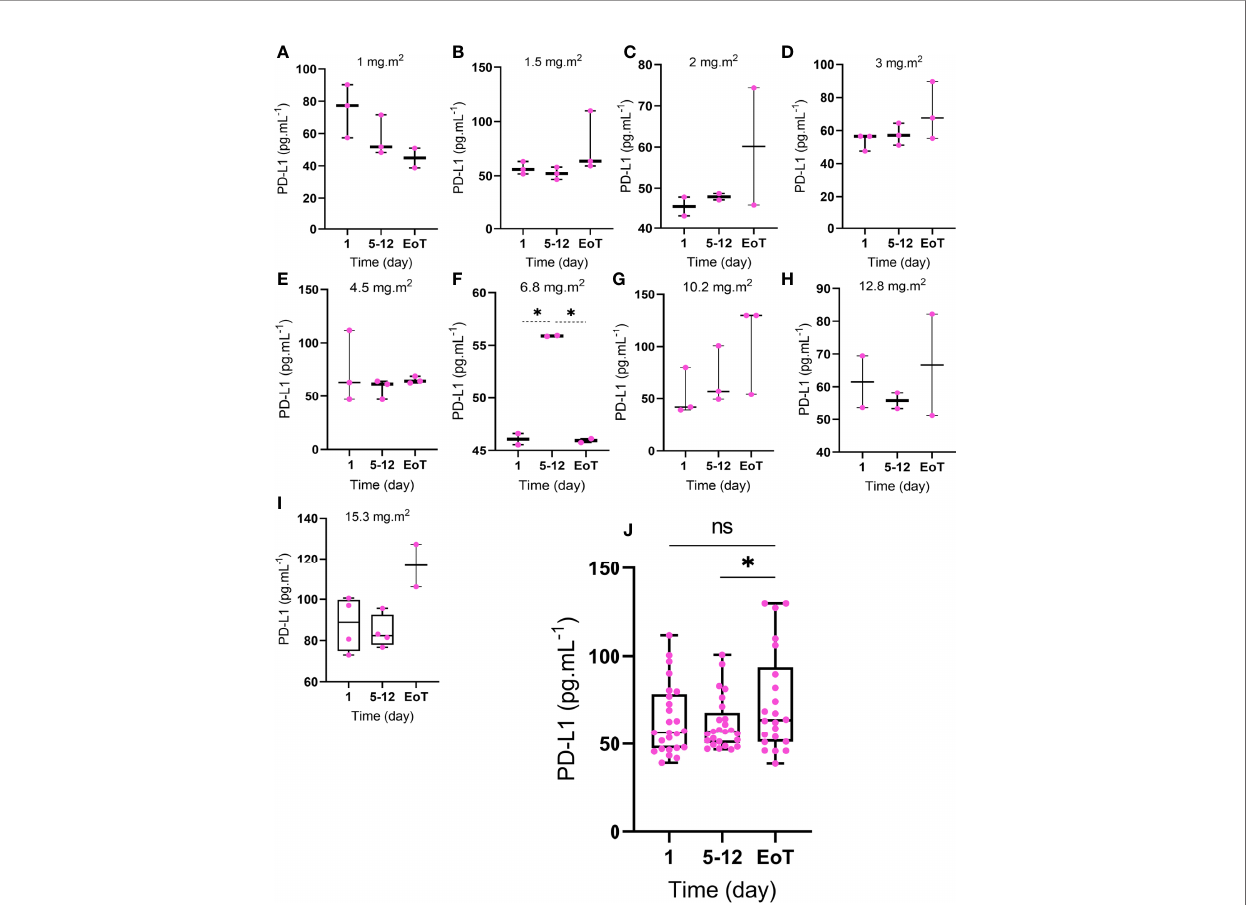
FIGURE 1 | Expression of PD-L1 in cancer patients following treatment with selenite. The participants are divided into different subgroups based on the dosage of selenite (A) 1, (B) 1.5, (C) 2, (D) 3, (E) 4.5, (F) 6.8, (G) 10.2, (H) 12.8, and (I) 15.3 mg.m 2 . The analysis was conducted in three-time points; BT: day 1 before treatment, TP: day 5-12 treatment period), and EoT: end of treatment. The combined data is shown ( Figure 1J ). Statistical signi fi cance (p ≤ 0.05) is marked by an asterisk (*). ns: not signi fi cant. (n=3, MEAN ±